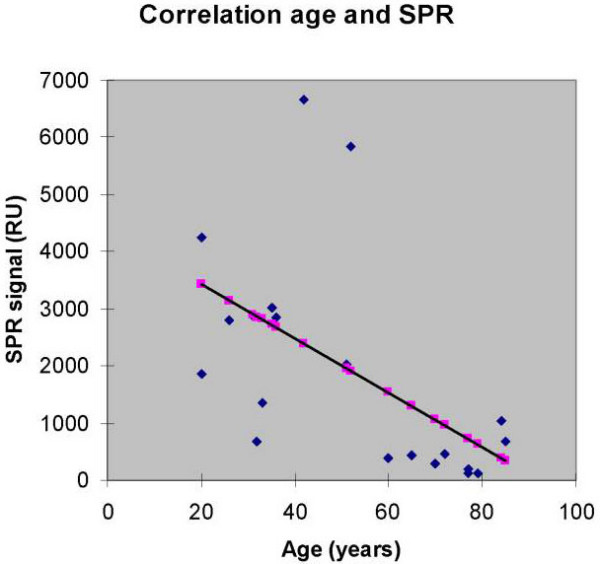
Correlation between age of the patients with infectious gastroenteritis and signal responses by SPR (Spearman rank correlation coefficient r = - 0.55, p = 0.01). The shadow points along the regression line are not data points.